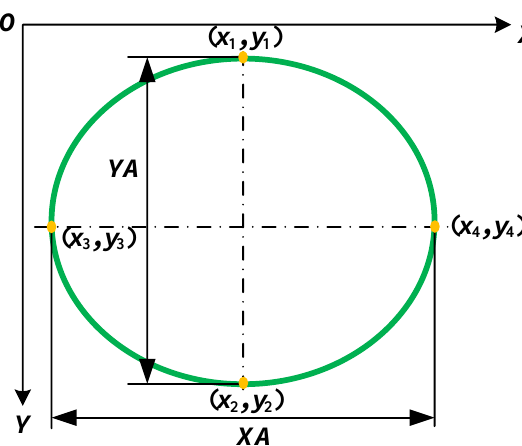
Figure 3. Keyhole edge extraction effect diagram: ( a ) raw image; ( b ) two-level threshold segmenta- tion; ( c ) elliptical curves fitting.